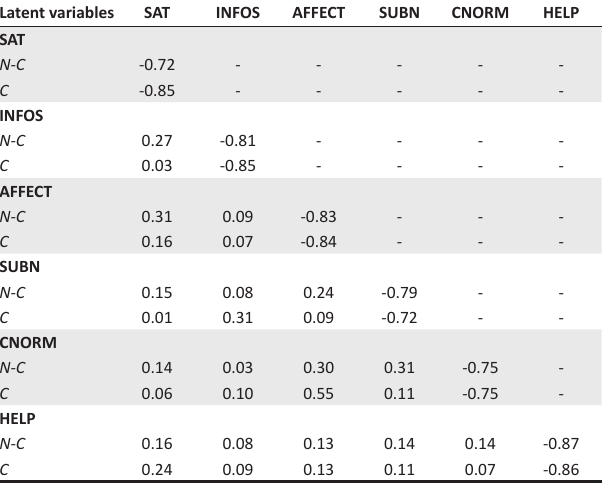
TABLE 3: Correlation matrix with the average variable explained on the diagonal. Latent variables